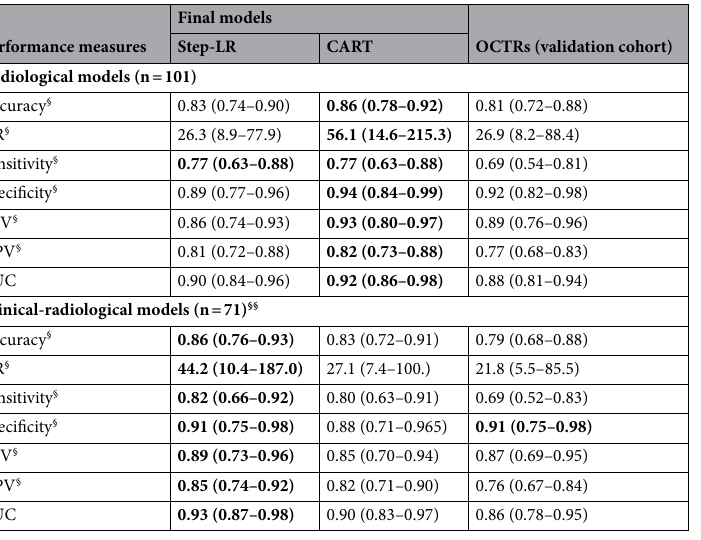
Table 5. Performances of the final, trained, multivariate models and on-call teleradiologists’ conclusions on the independent validation cohort. Regarding the teleradiologists’ performances, they correspond to conclusion = (1), (2), (3) or (4) versus conclusion = (5). Accuracy, OR, sensitivity, specificity, PPV, NPV and AUC are given with 95% confidence interval. The highest diagnostic performance measure for each line is highlighted in bold. AUC area under the ROC curve, CART classification and regression tree; NPV negative predictive value; OCTRs on call teleradiologists; OR odds ratio; PPV positive predictive value; Step-LR stepwise binary logistic regression. § The diagnostic performances are calculated after dichotomizing the predicted probability for RT-PCR + per 0.5. §§ Thirty of the 101 patients from the validation cohort were excluded because of missing values (all from clinical variables).